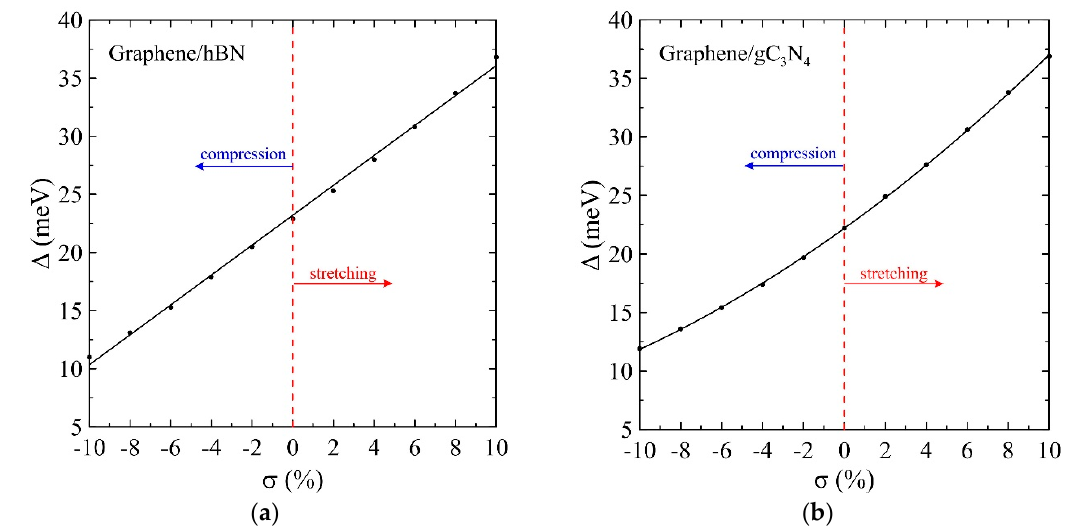
Figure 3. Semiconducting energy gap dependence on the uniform biaxial strain of the graphene deposited on the h BN ( a ) and g C 3 N 4 ( b ) substrates. Circles are the results of the calculation, and the solid lines are the least-squares linear ( a ) and quadratic ( b ) fits.